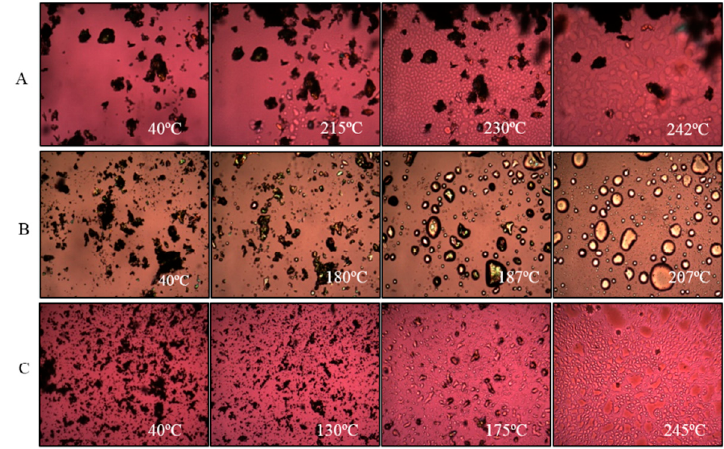
Figure 4. Representative hot-stage microscopy images for: ( A ) supplied L -leucine, ( B ) bedaquiline and ( C ) spray-dried bedaquiline with L -leucine.